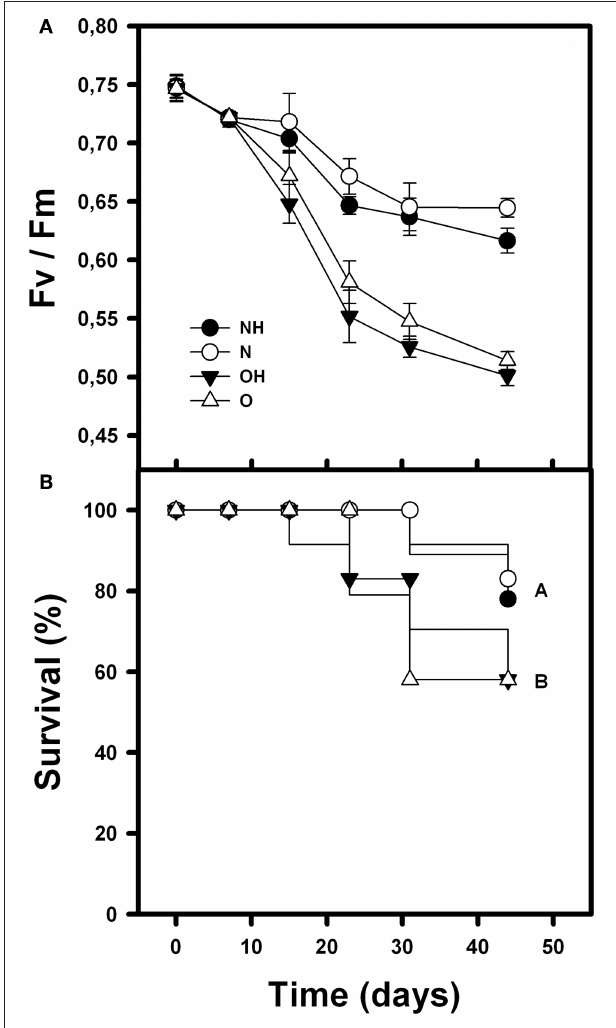
FIGURE 3 | Mean survival percentage (A) and photochemical efficiency “Fv/Fm” (B) during the recording time of B. fimbriata rosettes under the four treatments in the greenhouse: nurse-like conditions with (NH) and without (N) herbivory, and open spaces conditions with (OH) and without (O) herbivory. Different letters indicate significant differences.